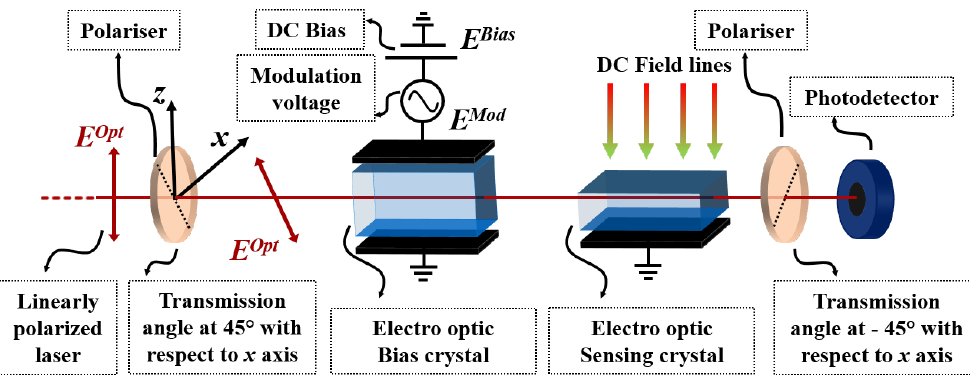
Figure 2. Schematic overview of the EO sensor for measurements of a DC electric